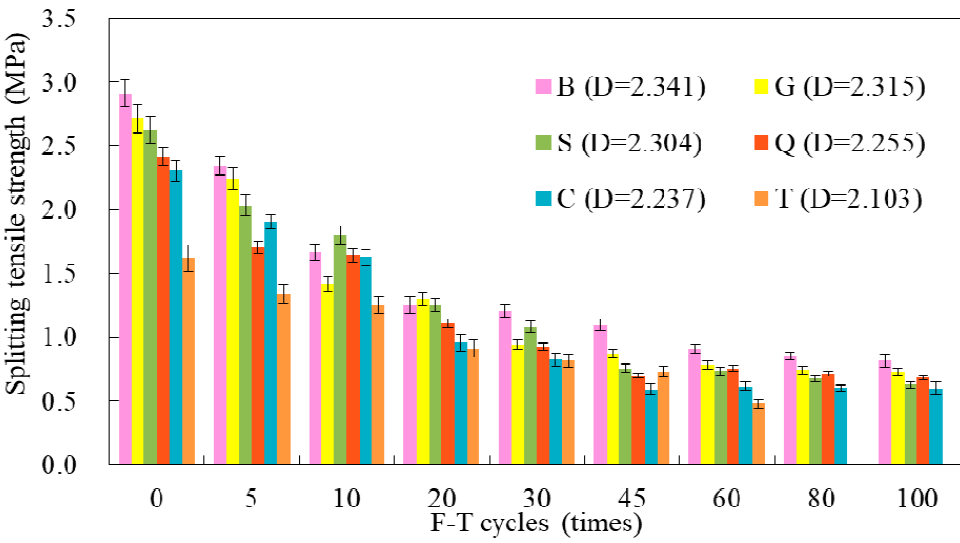
Figure 10. The splitting tensile strength of new-to-old concrete at 28 days under F-T cycles. The relationships between splitting tensile strength and the times of F-T cycles are shown in Figure 11. With the increase of F-T cycles, the splitting tensile strength increased as power function, and the specimens with different interface roughness met the relationship generally. The correlation coefficient R 2 arranged from 0.909 to 0.941. The splitting tensile strength of specimens showed an obvious two-stage change rule under F-T cycles. In the early stage of F-T cycles the strength dropped rapidly, and in the later period the loss of strength tended to be slow.